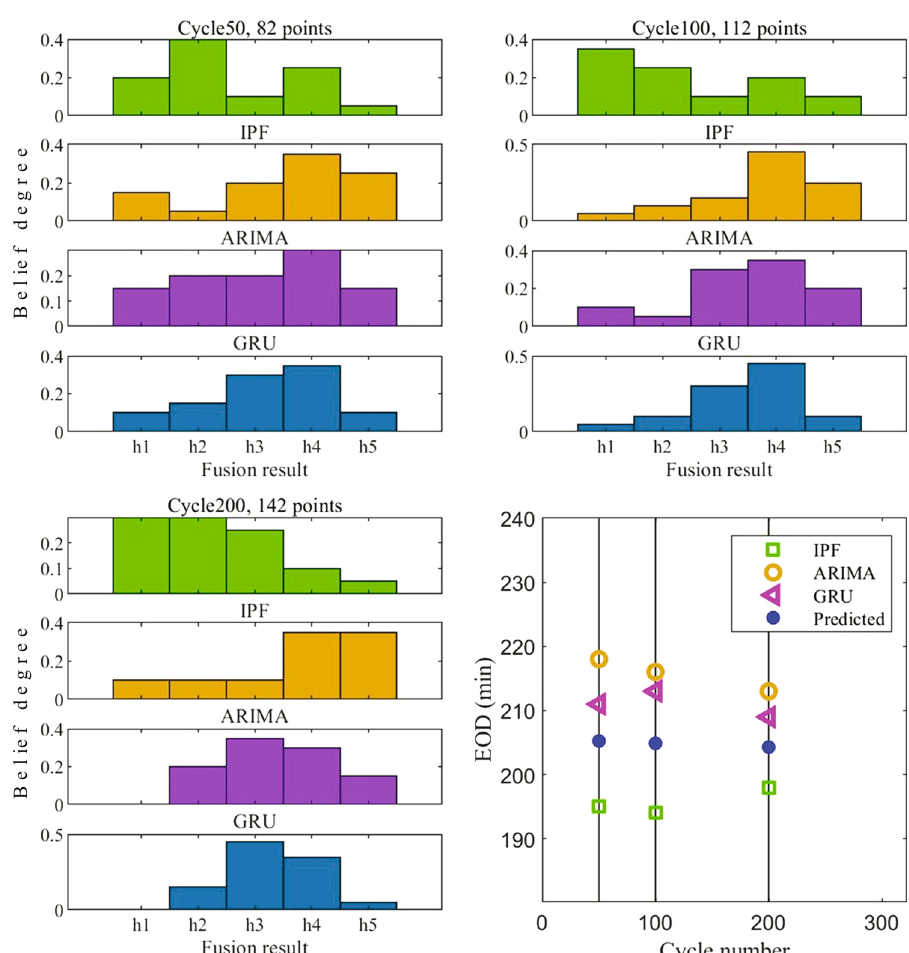
Figure 8: Comparison of predicted results for di ff erent